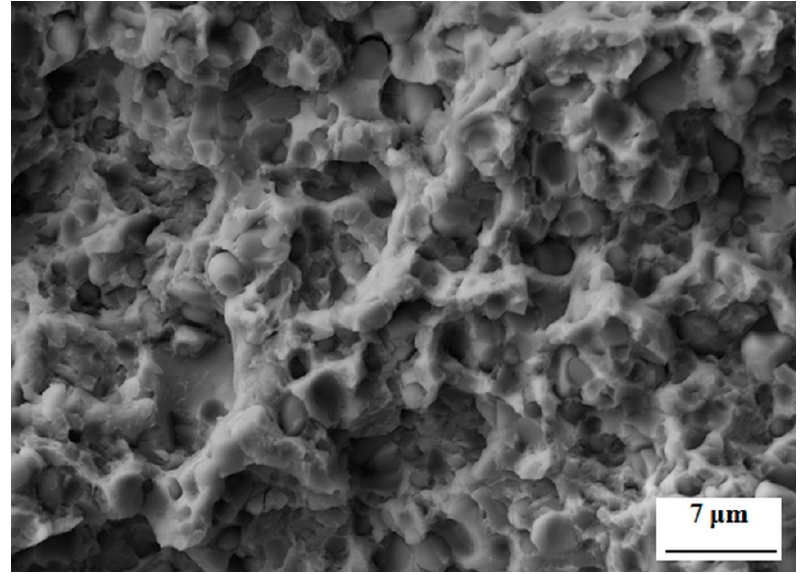
Figure 17. SEM micrographs showing the fracture surface of Cr 2 N–6Ag-coated Vanadis 6 steel.